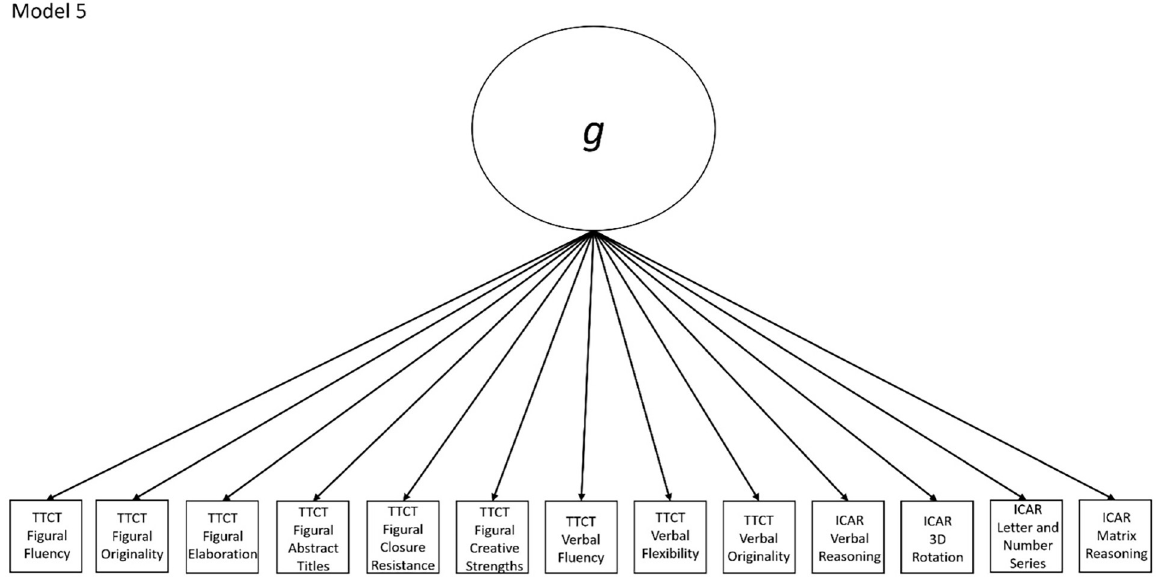
Fig 6. Confirmatory factor analysis diagram for model 5.